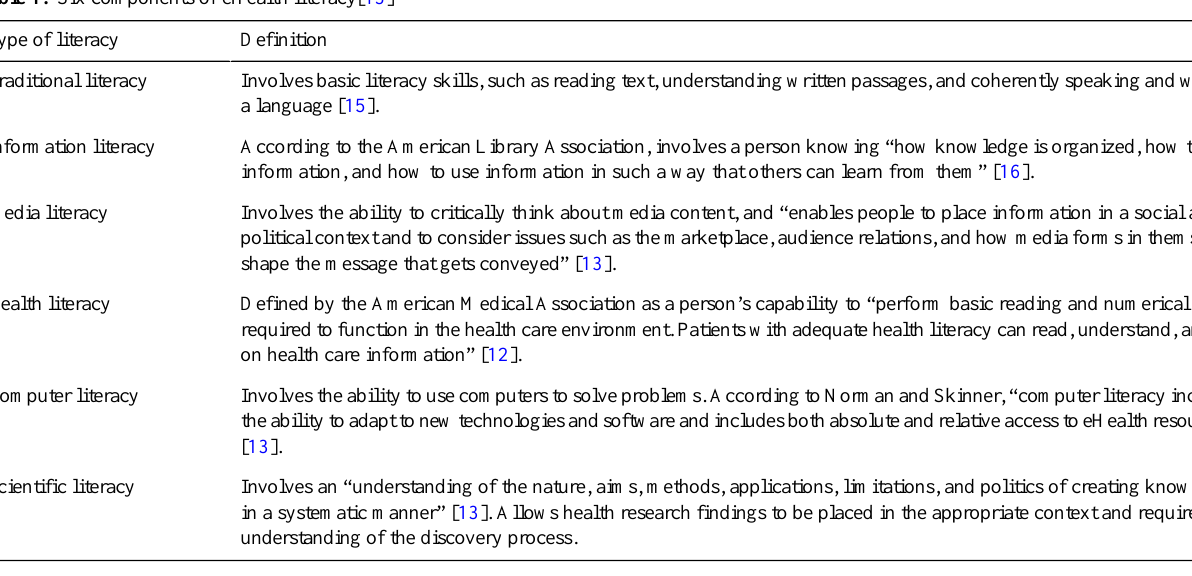
Table 1. Six components of eHealth literacy[13] DefinitionType of